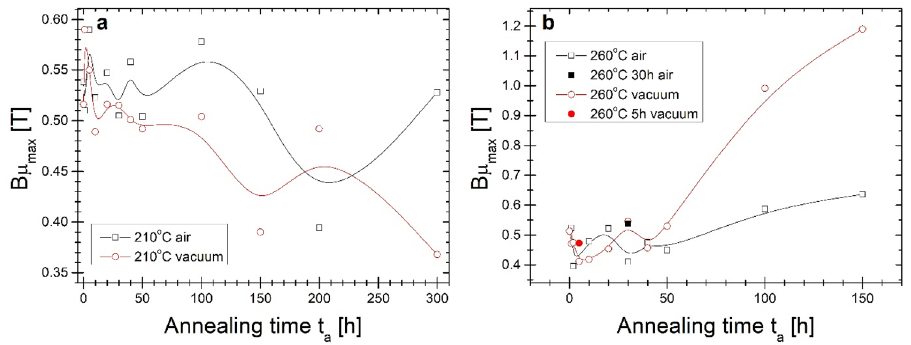
Figure 11. Bµ max on the annealing time of the isothermal process at ( a ) 210 °C and ( b ) 260 °C.